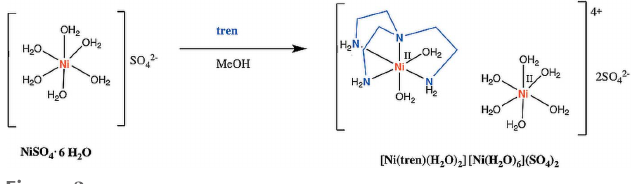
Figure 3 Reaction scheme for the synthesis of [Ni(tren)(H 2 O) 2 ][Ni(H 2 O) 6 ](SO 4 ) 2.